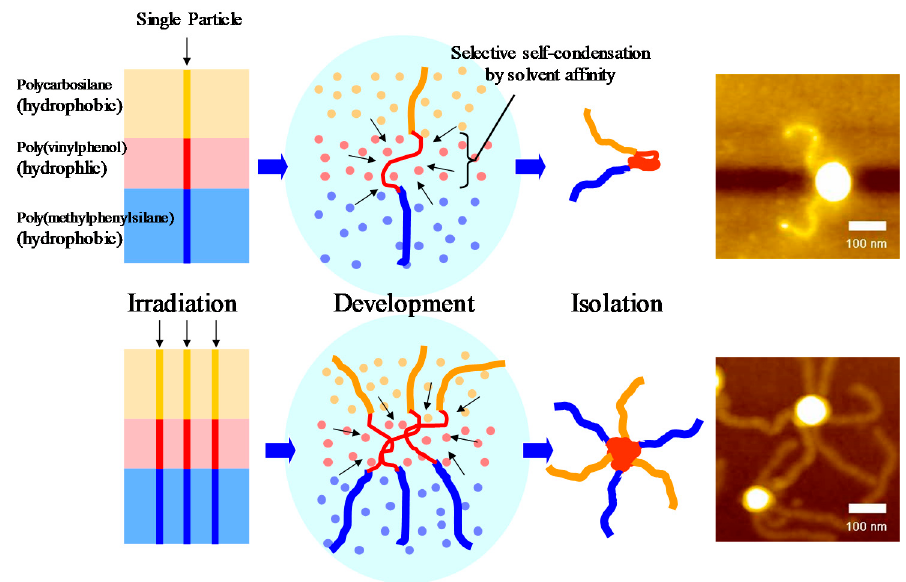
Figure 3. Selective self-entanglement of three-segment Figure3. Selectiveself-entanglement ofthree-segment poly(methylphenylsilane) / poly(hydroxystyrene) / poly(methylphenylsilane)/poly(hydroxystyrene)/poly(carbosilane) nanowires prepared by exposure poly(carbosilane) nanowires prepared by exposure of the corresponding film to 454 MeV 129 Xe 25 + ion of the corresponding film to 454 MeV 129 Xe 25+ ion beam at fluences of 1.1 × 10 9 (upper) and 5.3 × 10 9 beam at fluences of 1.1 × 10 9 (upper) and 5.3 × 10 9 ions cm − 2 (lower). Reproduced with permission ions cm − 2 (lower). Reproduced with permission from ref. [89] ©2006, American Chemical Society. from ref. [89] © 2006, American Chemical